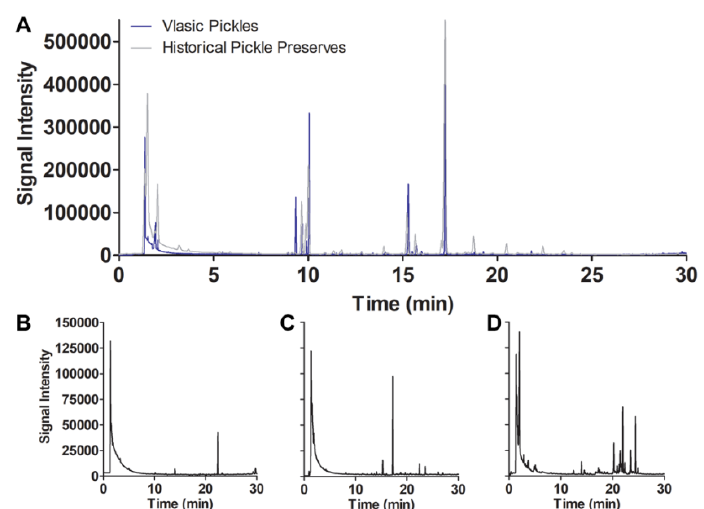
Figure 2. Total ion chromatograms (TICs) derived from 2 h SPME sampling of representative samples. Vlasic dill pickle (blue line) and historical preserve dill pickle type 2 (sample 29; gray line) TICs are overlaid to show similarities and differences in compounds detected and their intensities ( A ). Representative TICs of low (tomato sample 2; B ), medium (dill pickle sample 30; C ), and high (sweet pickle sample 31; D ) complexity samples. The y -axis labels and intensity presented in the panel B TIC are the same for panels C and D.